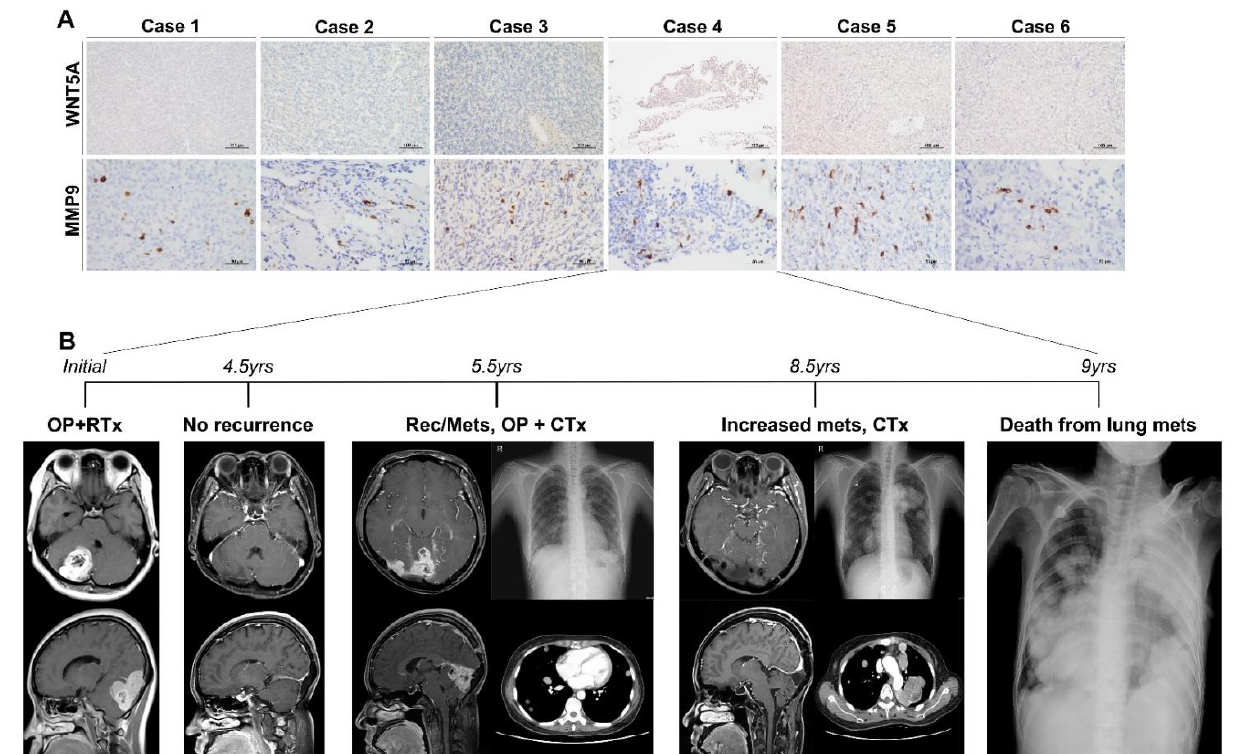
Figure 5. Cases of ic SFT/HPC exhibiting extracranial metastasis. ( A ) In all six cases, WNT5A expression was markedly decreased but that of MMP9 was significantly increased by IHC. ( B ) The clinical progression of case four was as follows: after surgical resection and radiotherapy, the patient showed no recurrence for four-and-a-half years. On follow-up imaging at five-and-a-half years postoperatively, the patient showed distant lung metastasis and local recurrence at the intracranial location. Surgical resection of the intracranial lesion and systemic chemotherapy were performed. At eight -and-a-half years after the initial operation, the metastatic lesions became widespread despite continued chemotherapy, and the patient died six months later.